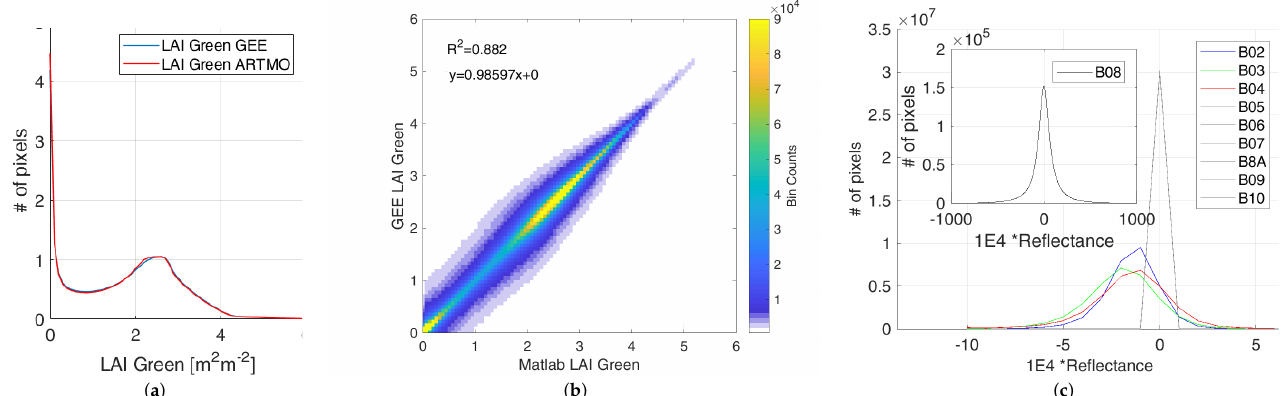
Figure 3. Comparison of green LAI maps estimated by ARTMO and GEE GPR implementations: histograms ( a ) and scatterplot density ( b ). In ( c ), the histogram of pixel-by-pixel difference between 10 m bands resampled at 20 m distributed by ESA and available in